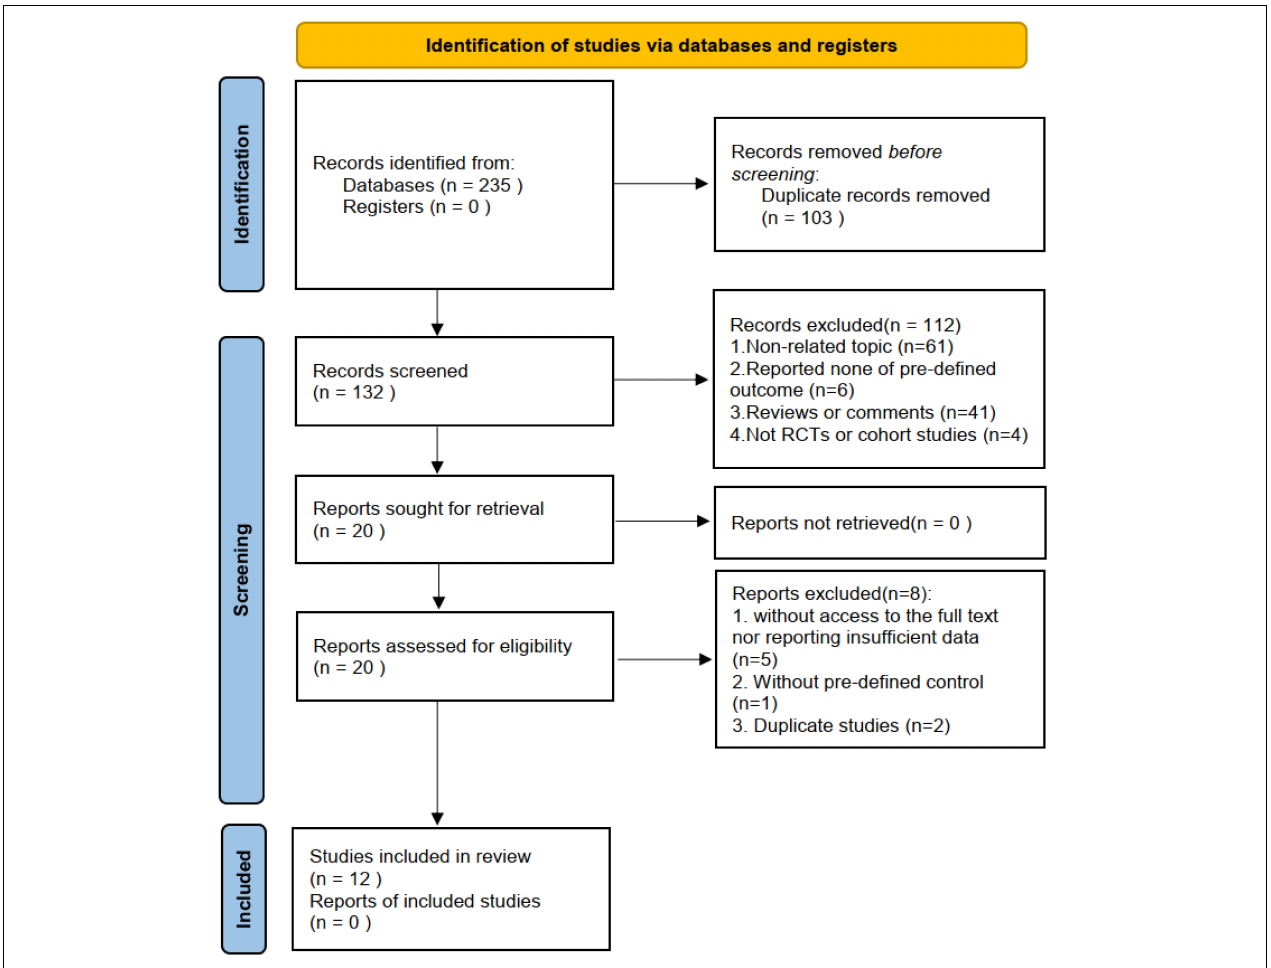
FIGURE 1 | The flow